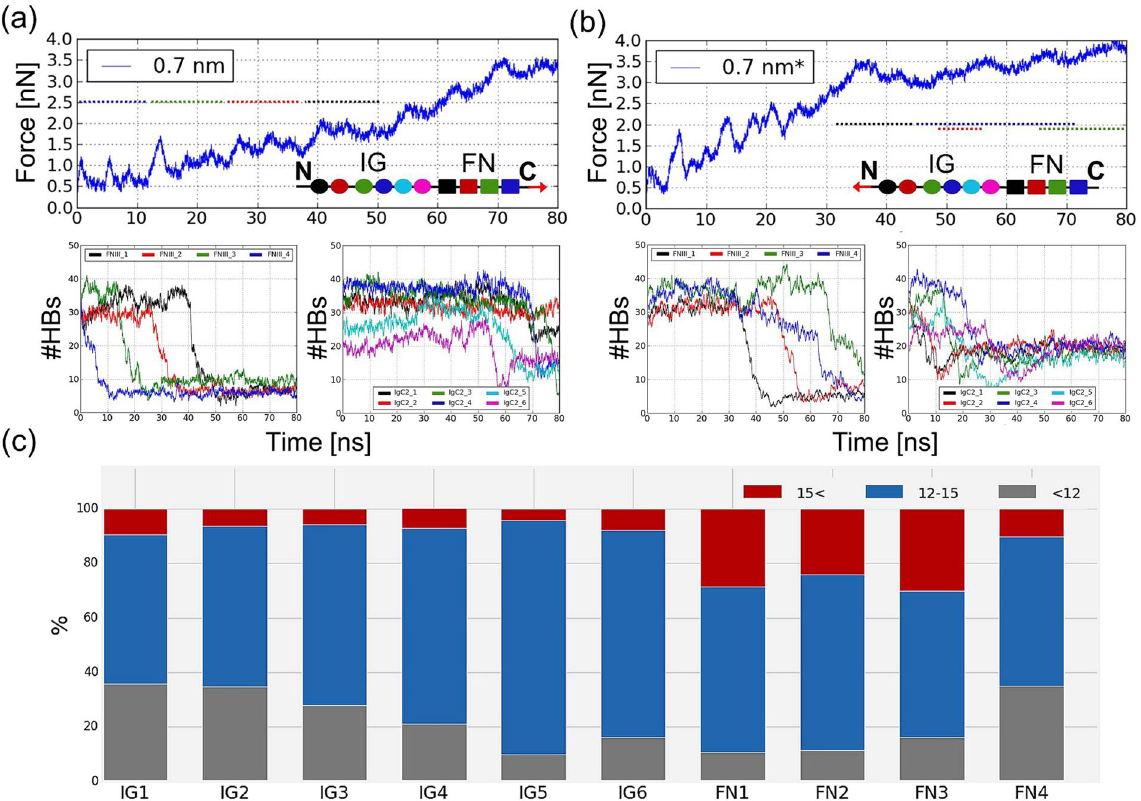
Figure 5. Results from SMD simulations of CNTN4. ( a,b ) For each simulation the time evolution of the experienced force under constant-velocity (0.025 Å/ps) pulling in silico experiments is shown ( top curves). On the botom , the time evolutions of the number of hydrogen bonds (#HBs) for the FnIII 1–4 and IgC2 1–6 domains are displayed. Simulations were performed in the presence of a water layer of thickness 0.7 nm. The modular structure of CNTN4 in the inset shows the direction of pulling (or the application of force, either to the N-terminus or to the C-terminus, indicated by the red arrow). The colors encode the corresponding CNTN4 modules. The dotted lines in the inset show the time period during which the secondary structure melting of an encoded FnIII domain took place. ( c ) Results from MechStiff calculations. The results provide information about the composition of effective spring constant ( k ) in the presence of external force for each CNTN4 module, grouped in three ranges: k < 12 ( gray ), 12 ≤ k < 15 ( blue ) and k ≥ 15 ( red ), corresponding to the softest, moderate and stiffest responses, respectively. For IgC2 domains only the part which is not protected by a disulfide bond was